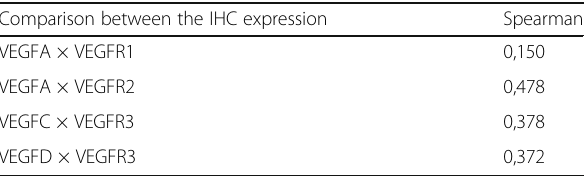
Table 6 Spearman rank correlation coefficients among VEGF subunits and their receptors Comparison between the IHC expression